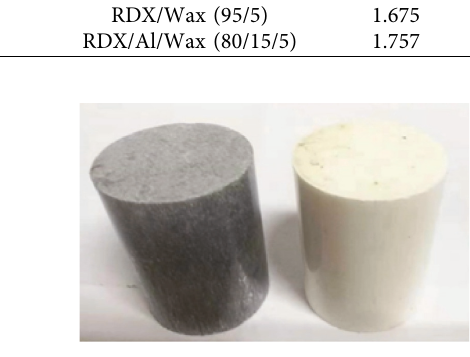
Figure 1: Experimental charge.